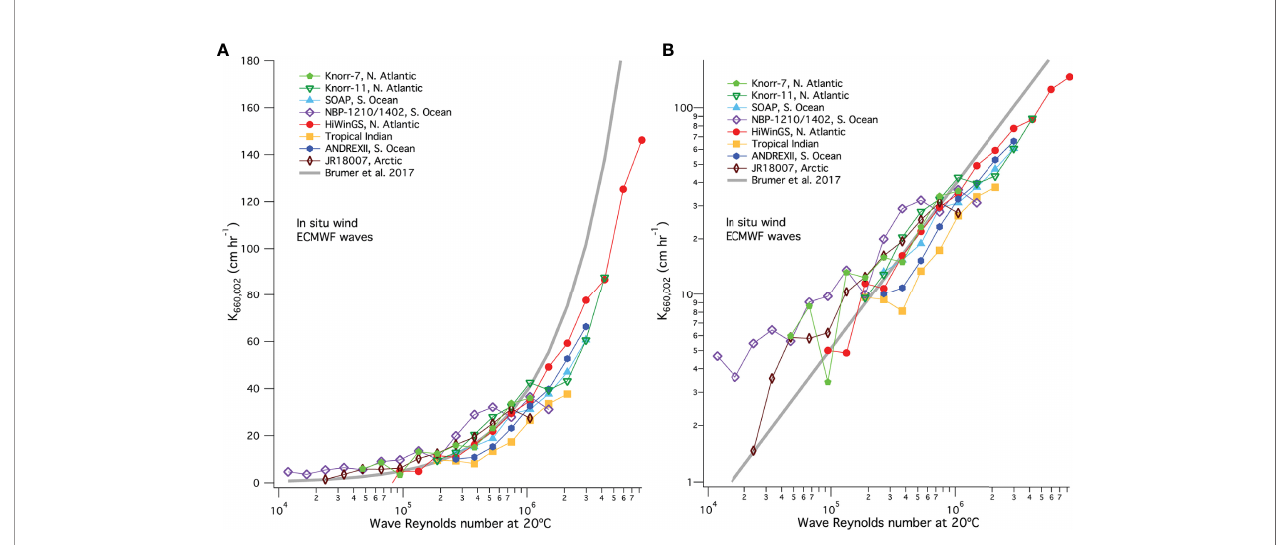
FIGURE 6 | K 660 averaged into bins of R Hw (20 °C) in semi-log scale (A) and log-log scale (B) .